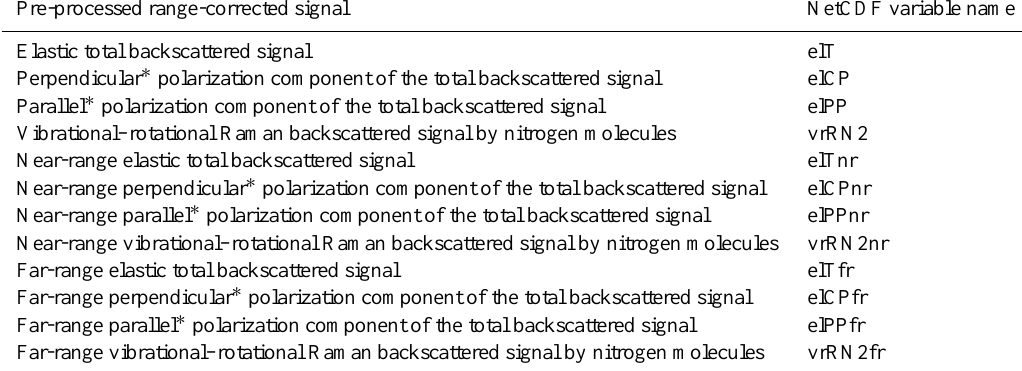
Table 1. Description of different types of pre-processed, range-corrected signals delivered by ELPP and the corresponding NetCDF variable name in the ELPP output files. All of the variables refer to a single emission wavelength. As a consequence, pre-processed data corresponding to different wavelengths are saved in separate